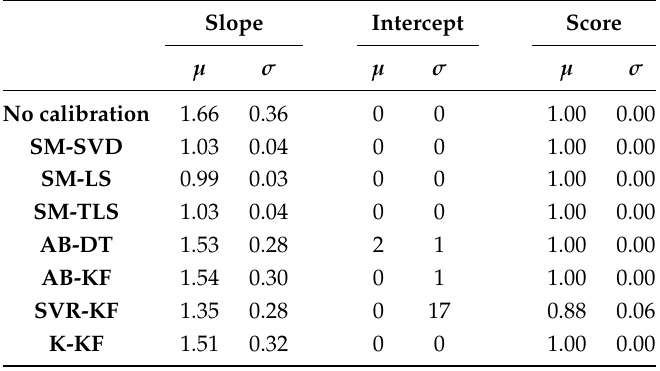
Table 6. Mean ( µ ) and standard deviation ( σ ) of the parameters of the error model and the regression score for s 1 , computed on each week of the drift period. The slope for SVR-KF varies significantly and the mean intercept is equal to zero with a standard deviation of 17. This is not the case for the other strategies. Thus, the observation made with Table 5 on SVR-KF is not valid locally and can explain why the mean score is poor compared to the ones obtained with the other strategies. Slope